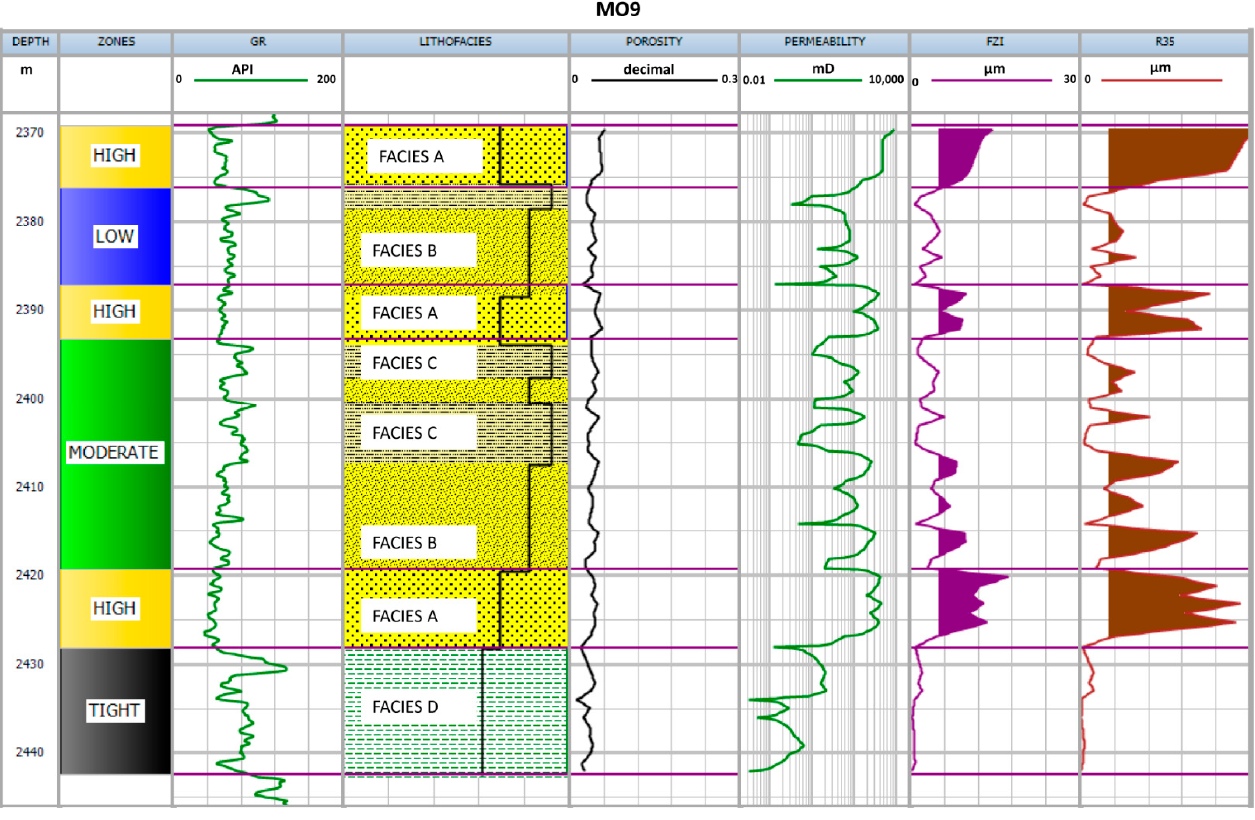
Figure 8. Results of well MO9 showing flow zones in track 2, gamma ray log in track 3, facies in track 4, porosity in track 5, permeability in track 6, FZI in track 7, and r35 in track 8.